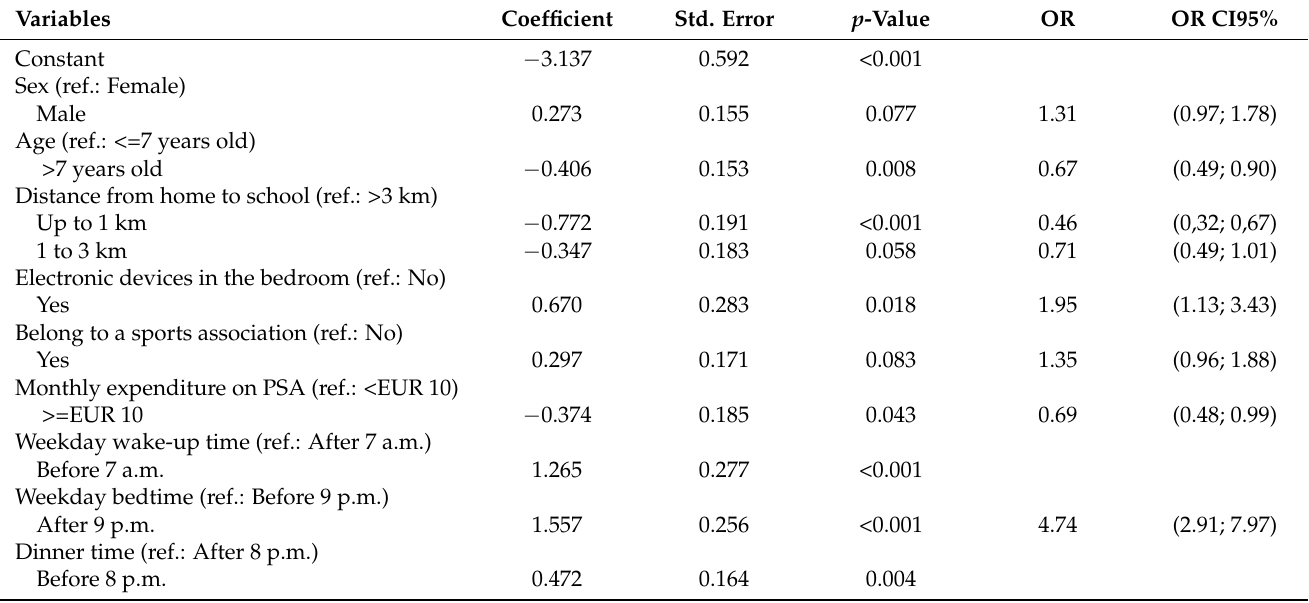
Table 4. Adjusted logistic regression model for the insufficient sleep time of the children. In this table, we present the coefficients of the model, the standard deviations, the p -values, the odds ratio (OR), and the 95% confidence interval obtained from the Wald